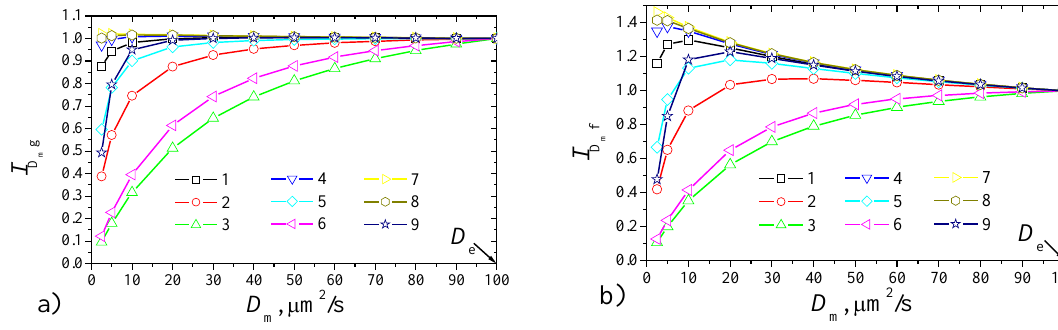
of the outer membrane in the cases m